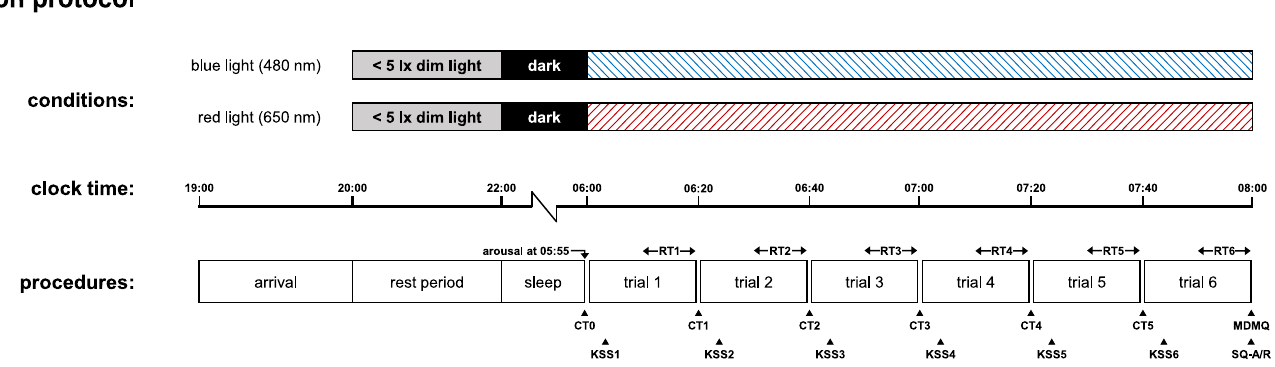
Fig 1. Schematic illustration of the applied within-subjects study protocol for both light conditions. Administration times for salivary cortisol sampling (CT0–CT5), auditory performance testing (RT1–RT6), and the assessment of sleepiness (KSS1–KSS6), sleep quality (SQ-A/R) and mood state (MDMQ) are explicitly indicated. Performing the experiments in an overnight sleep laboratory setting allows for strict control of the participants’ light history before sleep and ensures compliance. Participants were non-sleep-deprived as an approximate 8 h sleep opportunity was given before post-awakening light exposure.